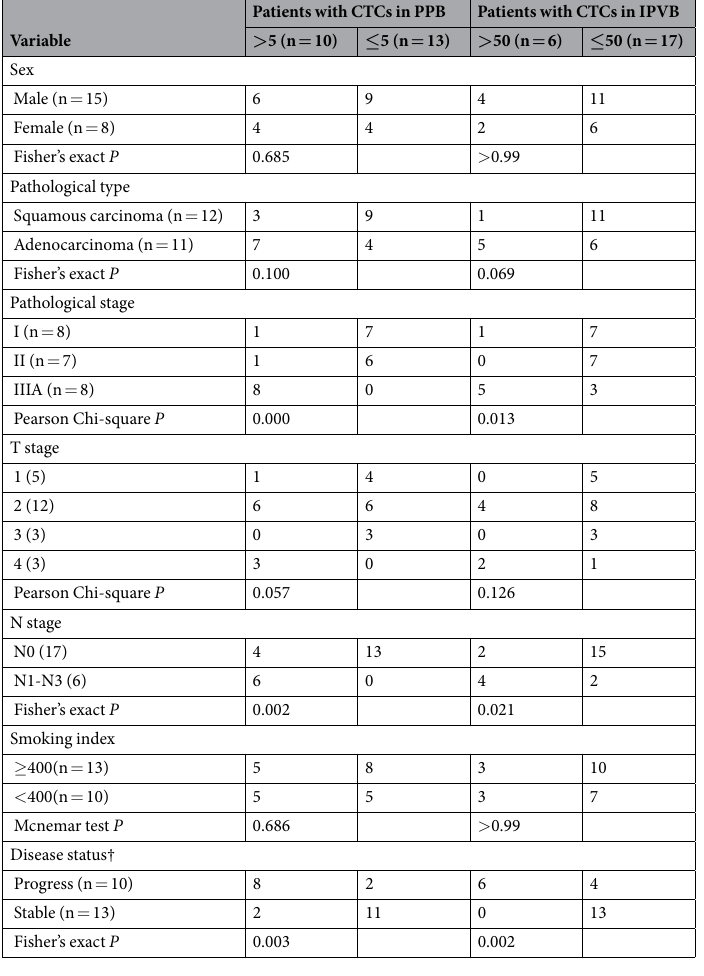
Table 2. Prevalence of circulating tumor cells and association with clinical features (n = 23) * . * CTCs circulating tumor cells, PPB preoperative peripheral blood, IPVB-CTCs intraoperative pulmonary venous blood. † Progression was defined according to the Response Evaluation Criteria in Solid Tumors. It meant metastases and recurrence occurring after surgical